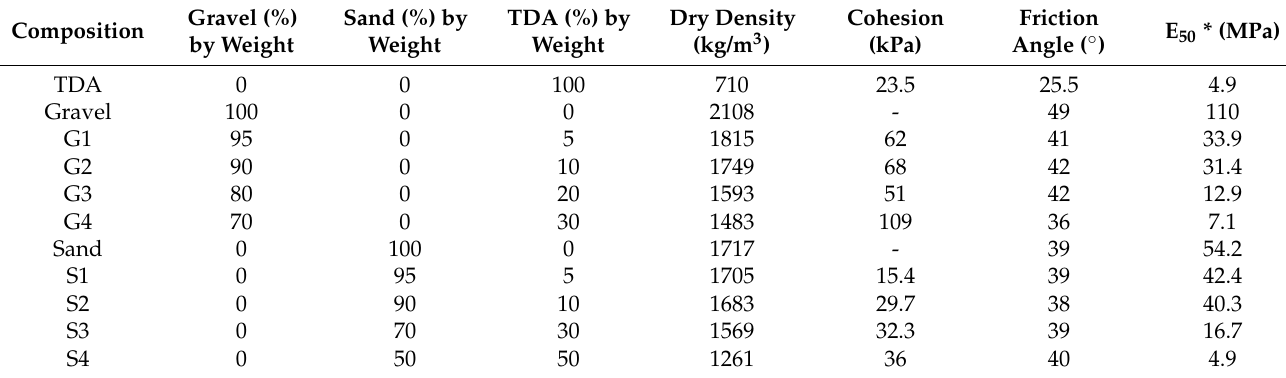
Table 1. Composition of specimens